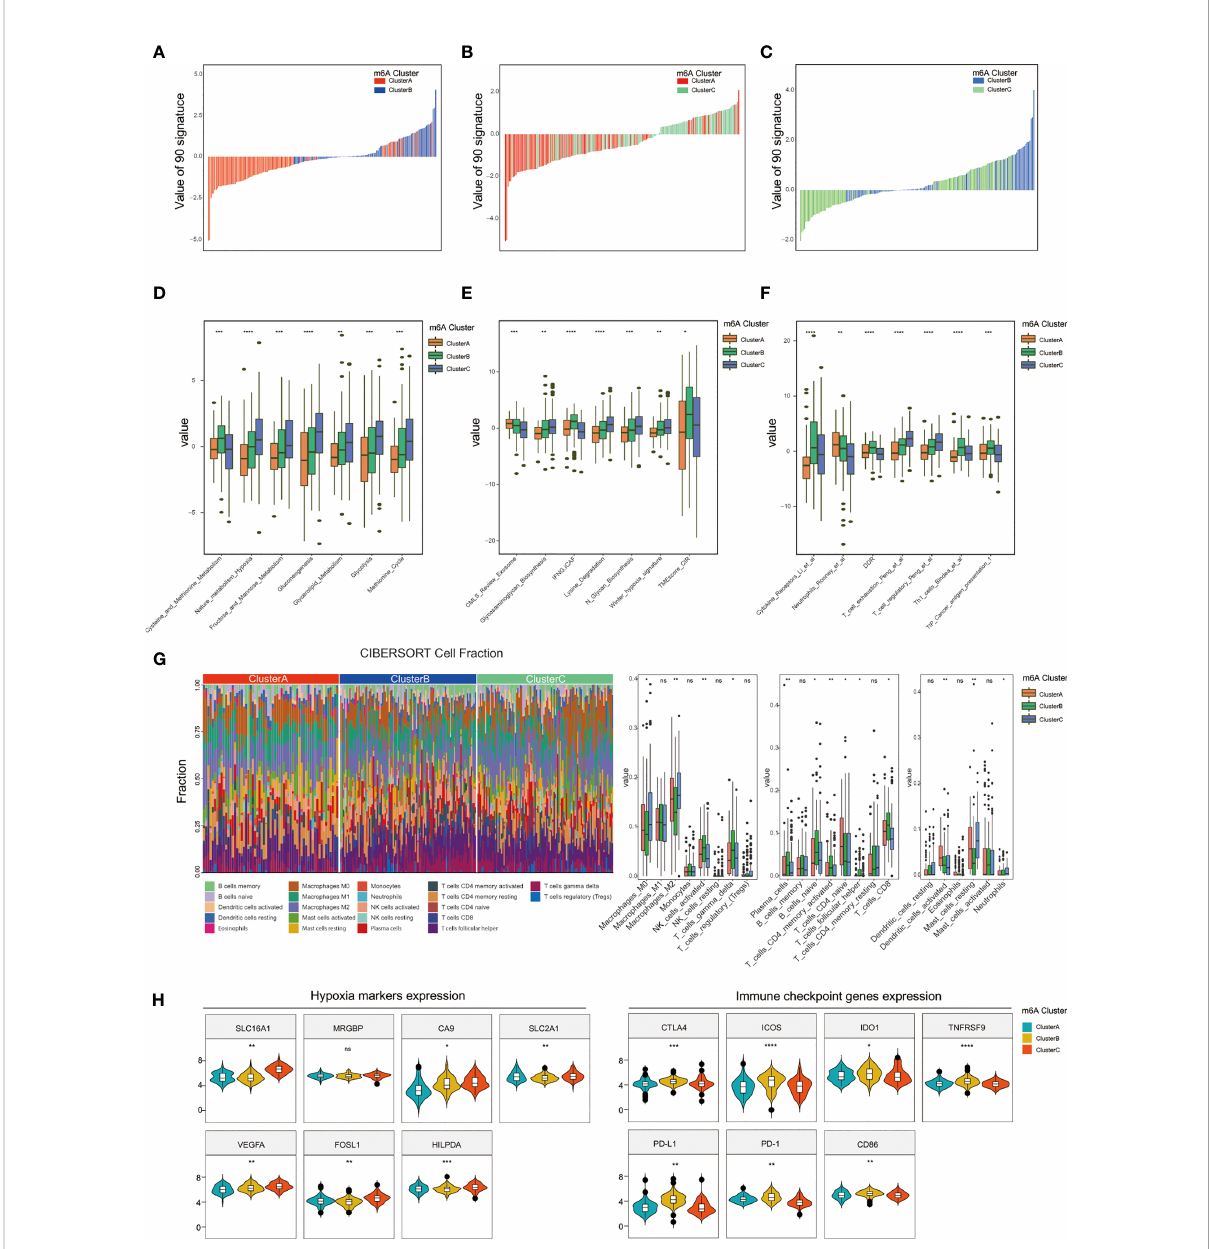
FIGURE 4 Comparison of TME and immune in fi ltration among m6A clusters. (A – C) The scores of 90 signatures among three m6A clusters. (D – F) Identi fi cation of 21 signatures differently scored in both m6A cluster1, m6A cluster2, and m6A cluster3. (G) Estimation and comparison of the immune in fi ltrated cells among three m6A clusters. (H) Distinct expression of hypoxia and immune checkpoint biomarkers between m6A cluster1, m6A cluster2, and m6A cluster3. (*P < 0.05,**P < 0.01, ***P < 0.001, and ****P < 0.0001). ns, not signi fi